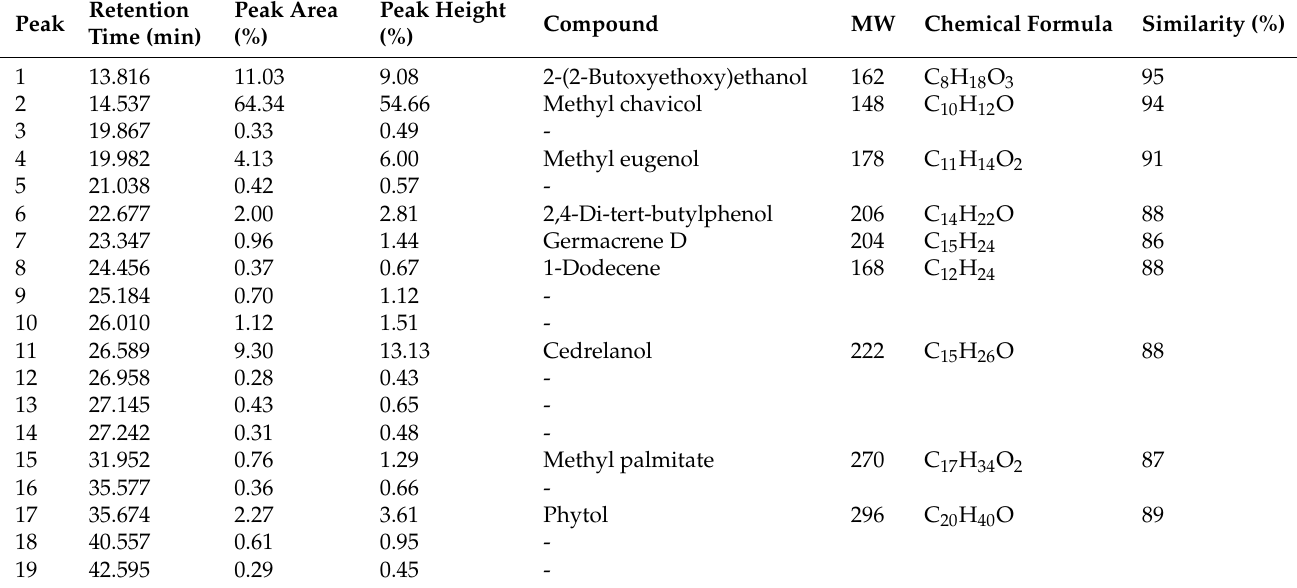
Table 3. Phytochemical profiling of the subfraction H-F345-S3 derived from the hexane extract of the leaves of O. basilicum using gas chromatography–mass